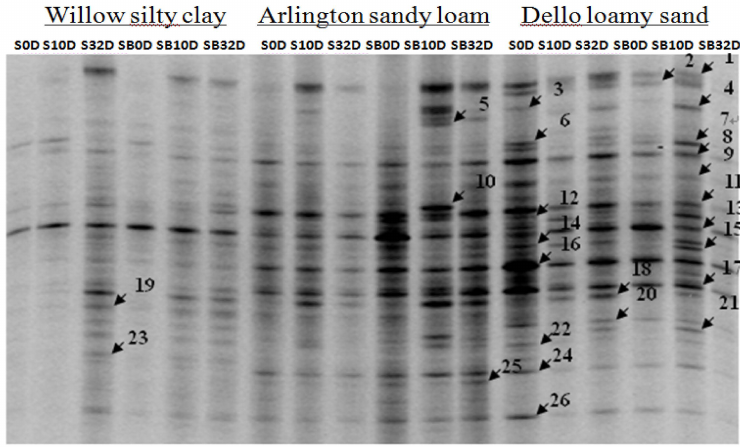
Figure 2. DGGE banding patterns of 16S rDNA fragments. Numbers indicate the excised and sequenced 16S rDNA bands. Lane labels denote samples from the treatments in this study (S0D, S10D, S32D: soils untreated and sampled in 0, 10 and 32 day. SB0D, SB10D, SB32D: B subtilis B068150-NR was introduced in to soils and sampled in 0, 10 and 32 day.)